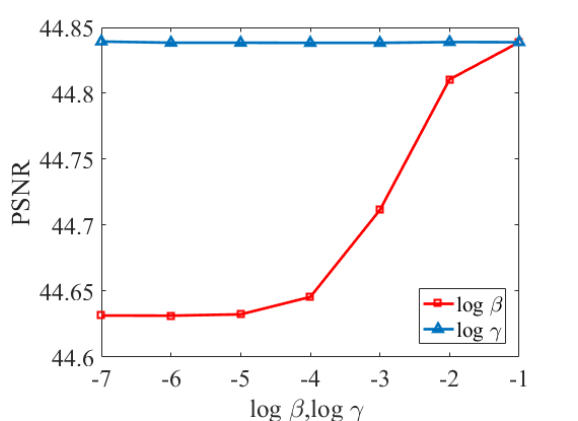
Figure 6. PSNR values for different log β and log γ .